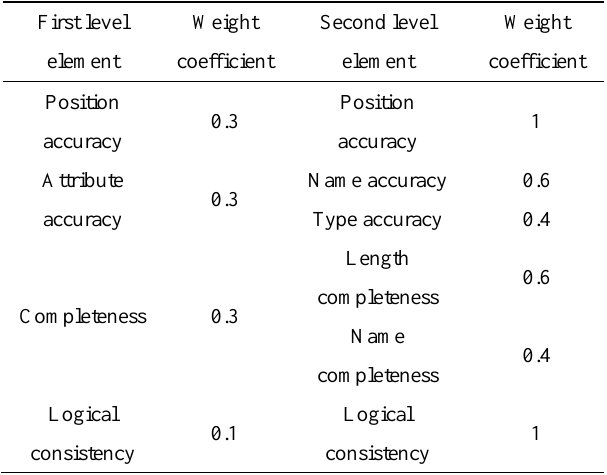
Table 1 quality element and weight